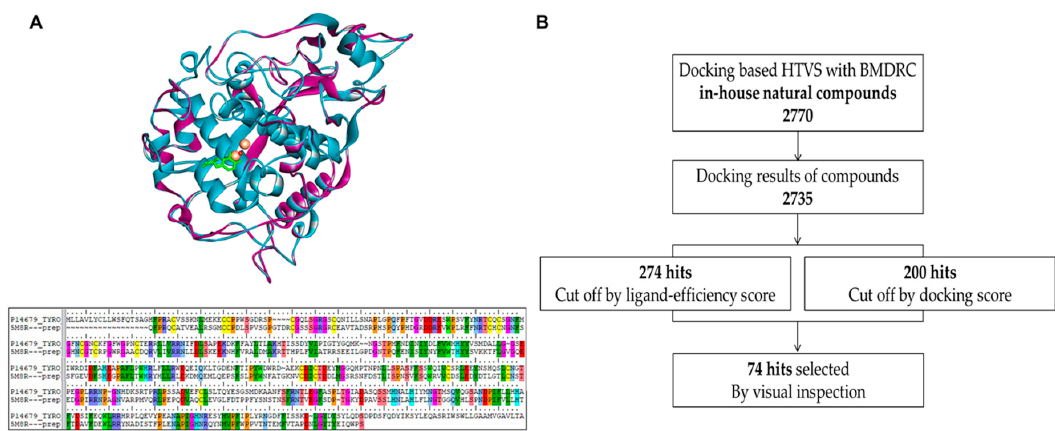
Figure 1. Homology modeling of human tyrosinase and docking-based high throughput virtual screening ( A ) Superimposed protein structures (top) and aligned protein sequences (bottom) of human tyrosinase model (cyan) and a human TRP1 protein template (PDB 5M8R: purple): the copper ions and co-crystalized ligands (including a water molecule) are represented by spheres (salmon) and sticks (green), respectively. ( B ) The schematic diagram shows the process of docking-based high throughput virtual screening (HTVS).